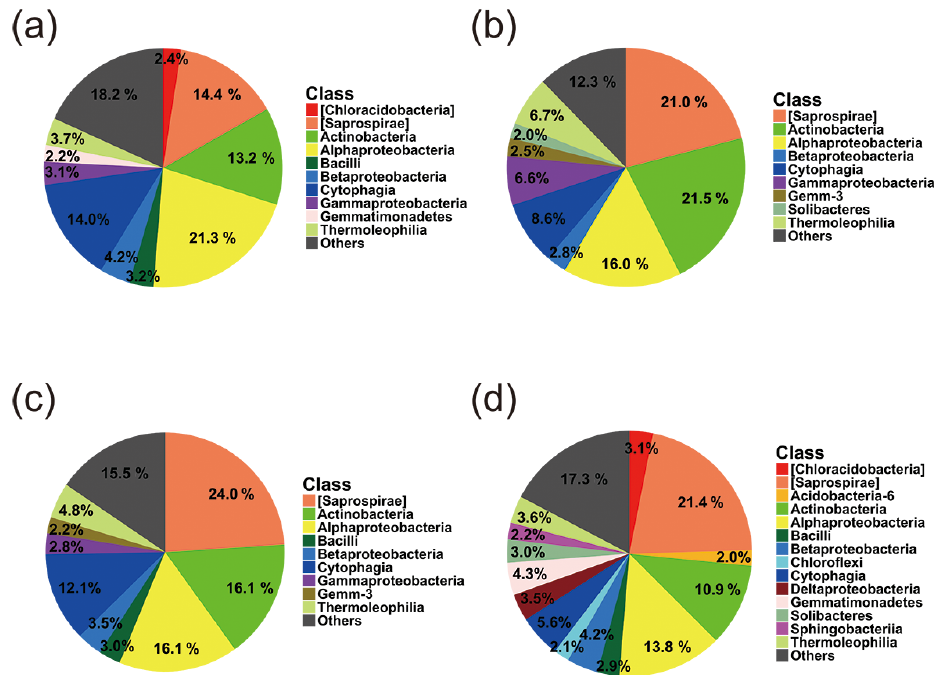
Figure 15. Variations in the bacterial community composition at the class level in (a) dust samples of Erenhot, (b) non-dust samples of Erenhot, (c) dust samples of R-DzToUb, and (d) non-dust samples of